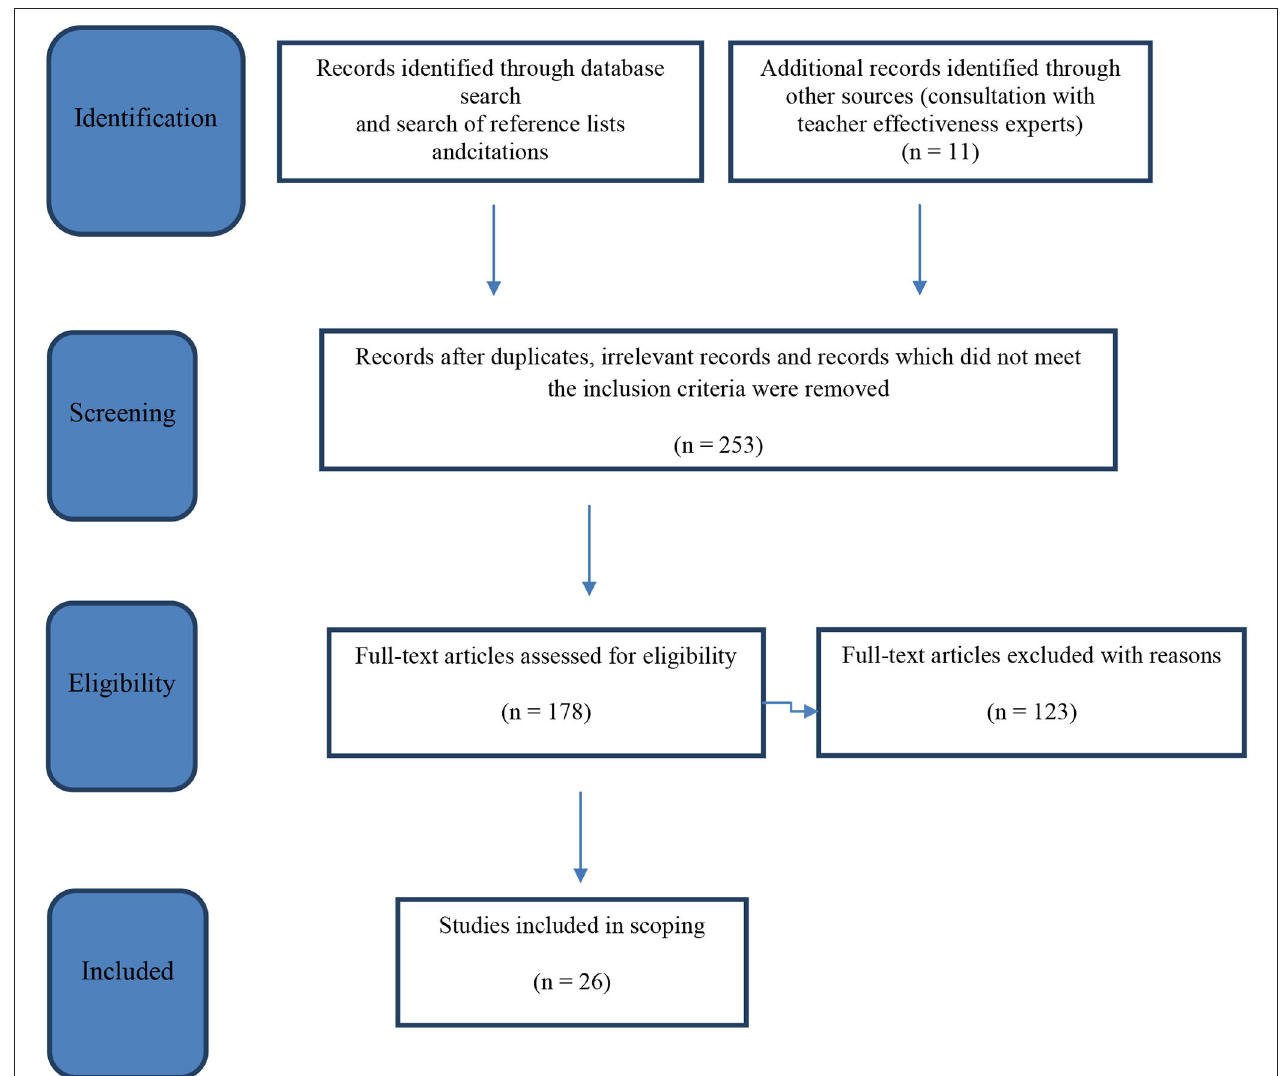
FIGURE 1 | PRISMA flow diagram (adapted from Moher et al.,